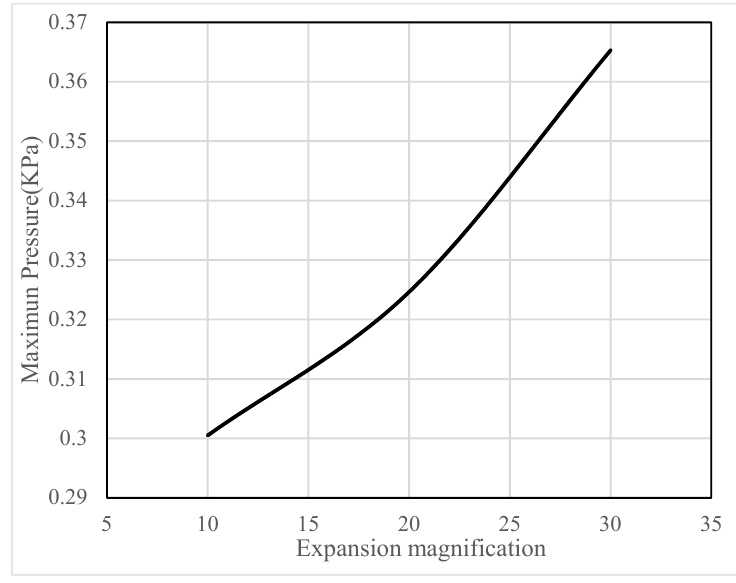
Figure 15. Relation curve between maximum pressure and expansion ratio. Table 3. Velocity values at different positions on the fracture